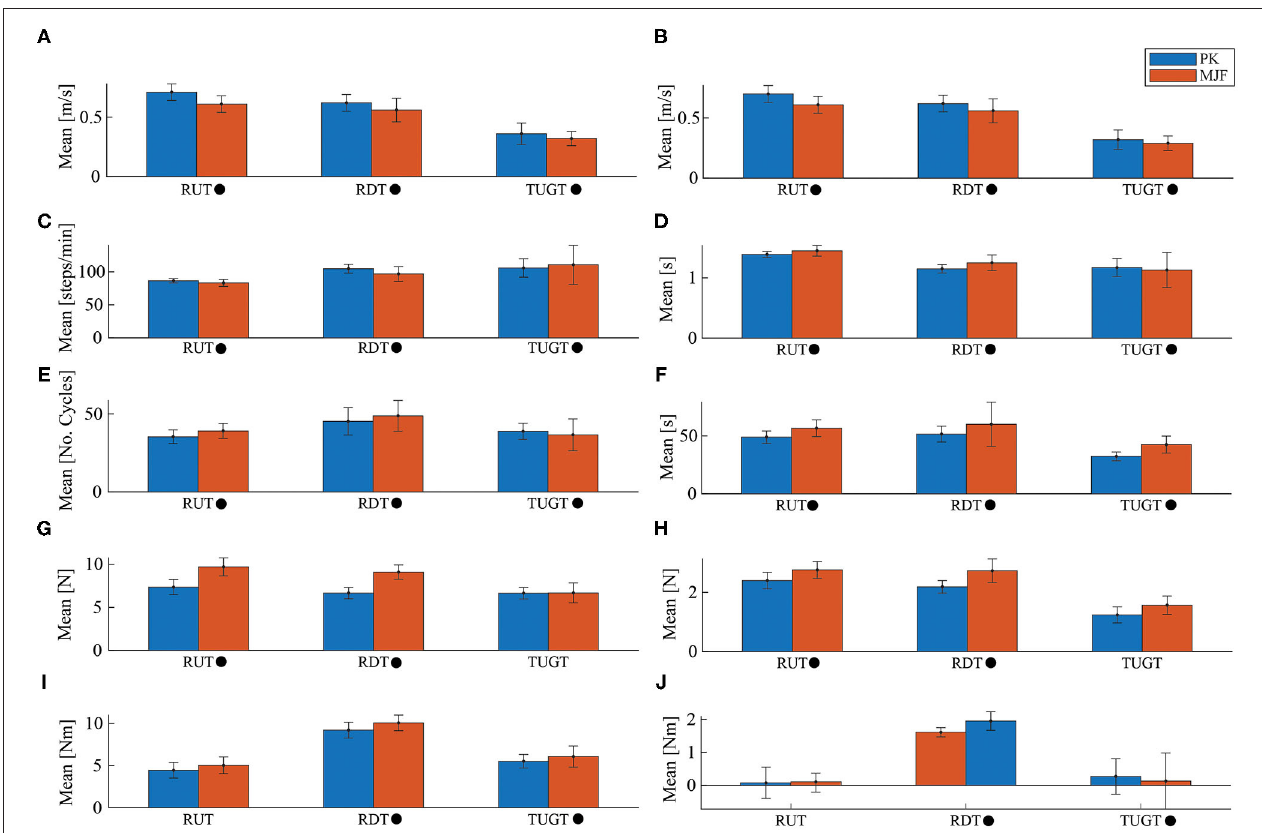
FIGURE 6 | Illustration of the kinematic and physical interaction data obtained for the three tests. Where RUT is Ramp Up Test, RDT is Ramp Down Test, TUGT is Timed Up and Go Test, Parkinson group (PK) corresponds to the group of older adults with Parkinson’s disease (PD) and MJF the group with metabolic and joint diseases and fractures. • indicates that there were significant differences between the groups evaluated. (A) User Speed. (B) SW Speed. (C) Cadence. (D) Cycle Duration. (E) No. Cycles. (F) Trial Duration. (G) Max frc_y. (H) Mean frc_y. (I) Max trq_z. (J) Mean trq_z.